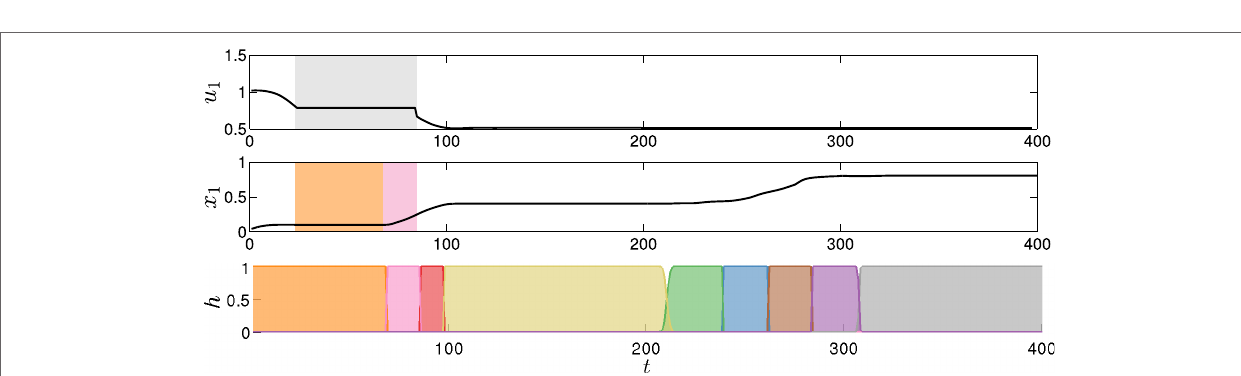
FIGURE 7 | Evolution in time of the proactive behavior variables . Top: first dimension of the user hand position. The hand does not move during the period marked by the shaded area. Middle: dimension x 1 of the robot end-effector position in task space. The state transition (shaded areas) marks the start of the proactive behavior. Bottom: rescaled forward variable h t,i